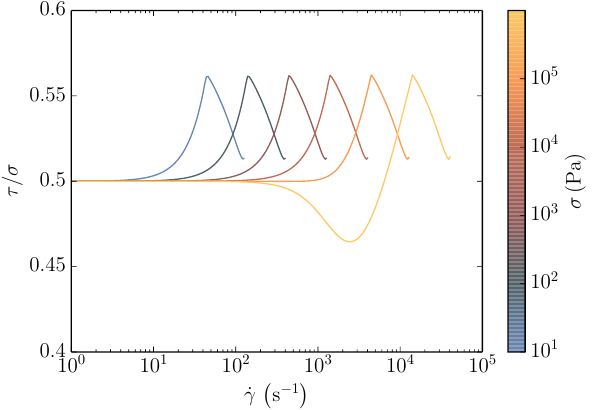
Figure 6. Contribution of enduring force chains: stress ratio τ q /σ .